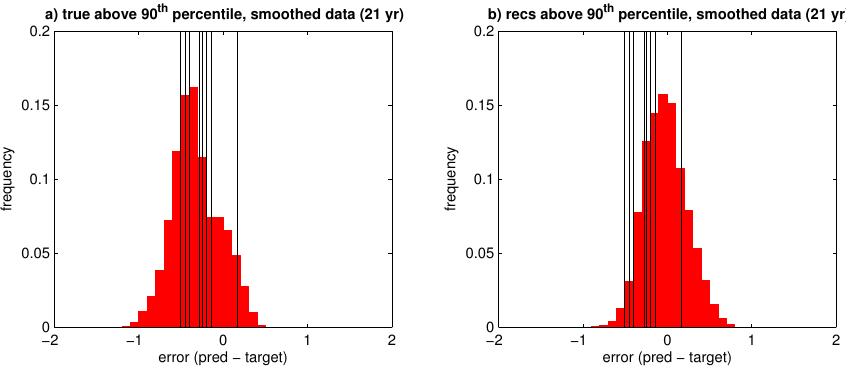
−2 −1 0 Figure 9. Pseudo-reconstructions’ accuracy in describing interdecadal positive PNA phases. Histograms are ensemble (all simulations) empirical probability distributions of residuals (predicted value minus true value) from the winter PNA pseudo-reconstructions obtained following an approach similar to TT2010 and illustrated in Figs. 7a and 8 for (a) target 21-year smoothed PNA values above the 90th percentile and (b) pseudo-reconstructed 21-year smoothed PNA values above the 90th percentile. The black vertical lines indicate the full period average residuals from individual simulations. Ninetieth percentiles are calculated over the full simulation and therefore reflect also full period biases in the pseudo-reconstructions. The smoothing is meant to mimic the approximately 20-year duration of the early 19th- century positive PNA phase in the TT2010 reconstruction. The considered positive PNA phases are sampled throughout the simulations, regardless of their